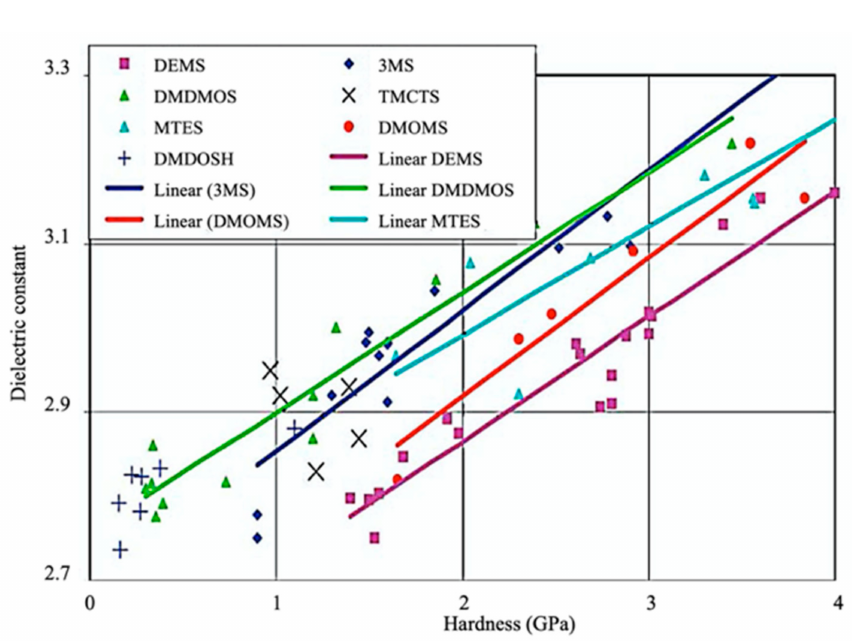
Figure 3. Dielectric constant vs. hardness for different precursors